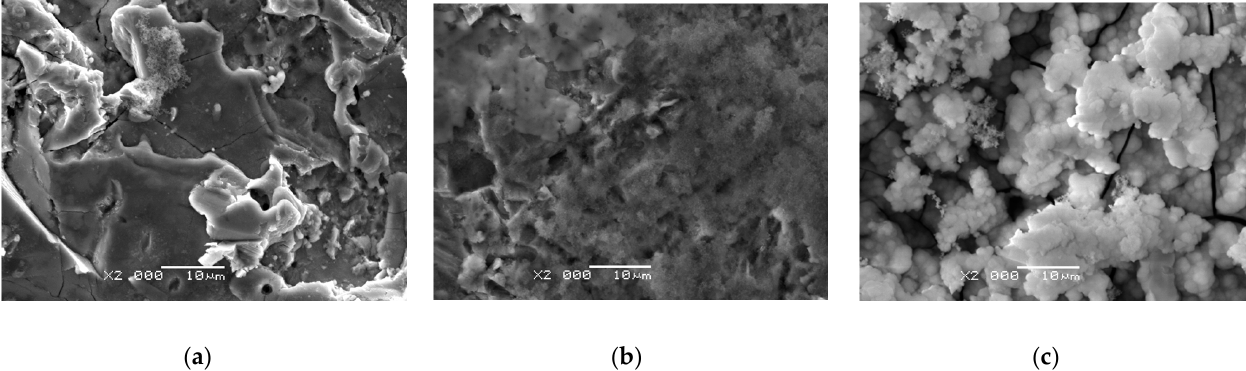
Figure 9. SEM image of the surface of CpTi G4 substrate mechanically polished, sandblasted and sterilized after bioactivity test for ( a ) 1, ( b ) 3, and ( c ) 7 days of immersion in SBF at 36.6 °C (×2000 magn.).